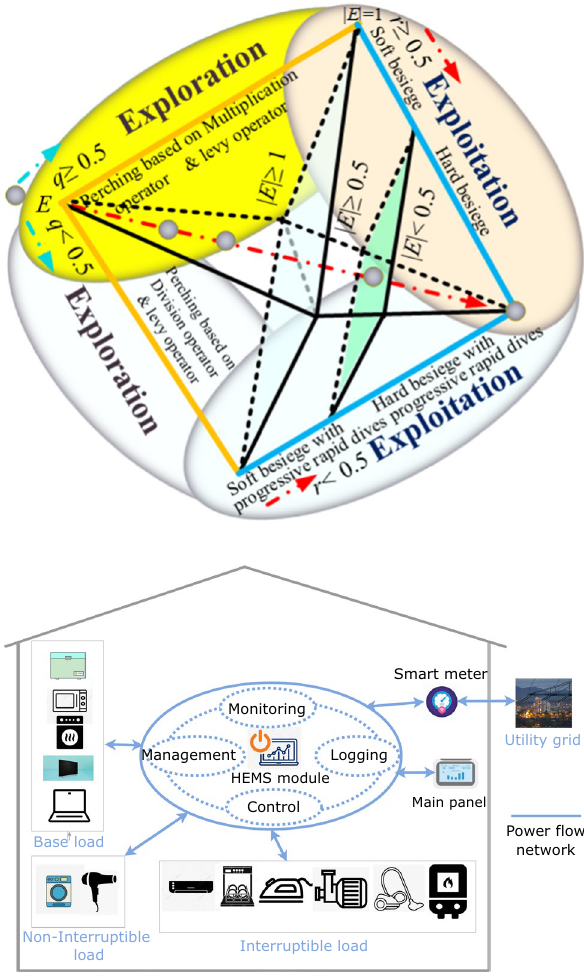
Fig. 3 Different steps of AHHO